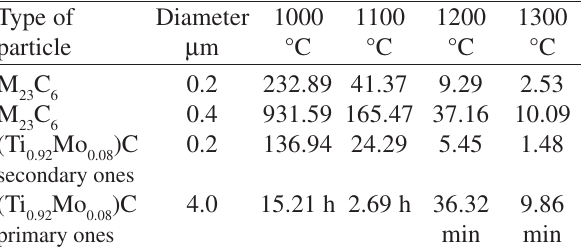
(Ti Mo )C particles by using Aaron e Kotler’s model. The di- 0.92 0.08 ameters used in this calculation are typical of the samples of this work. For the (Ti Mo )C case, the times were obtained for the 0,92 0,08 primary and secondary